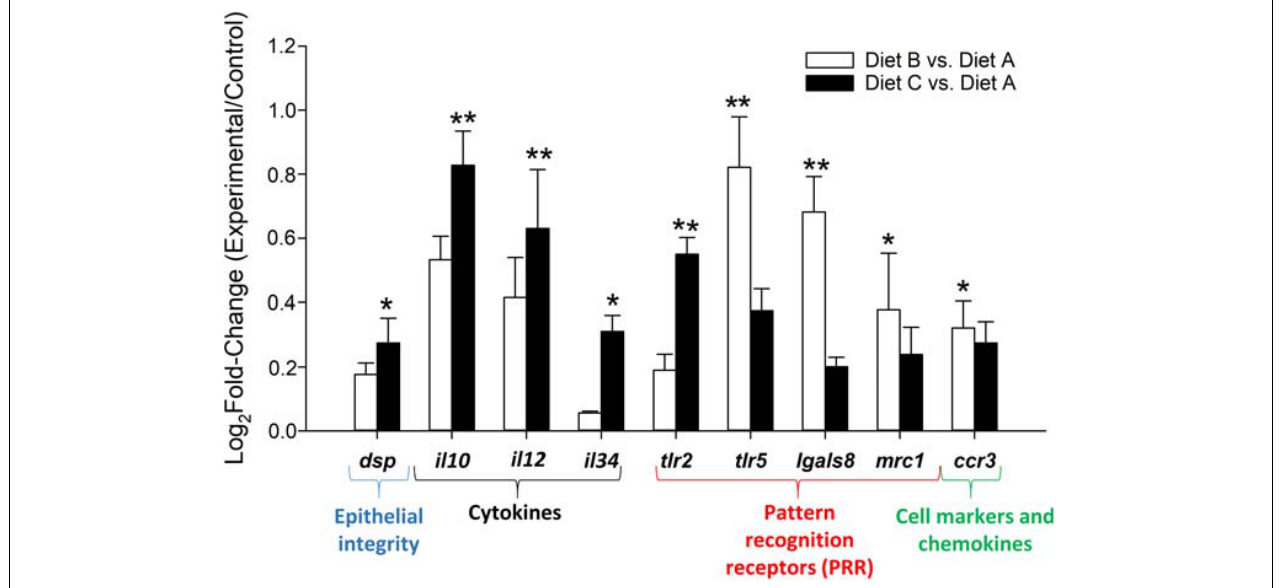
FIGURE 2 | Fold change of differentially expressed genes (Dunn’s post hoc test; ** P < 0.05; * P < 0.1) in the anterior intestine of fish fed experimental diets (diets B and C) relative to the control diet (A). Data are the mean + SEM of 9–12 fish per diet. White columns (fish fed diet B). Black columns fish fed diet C.